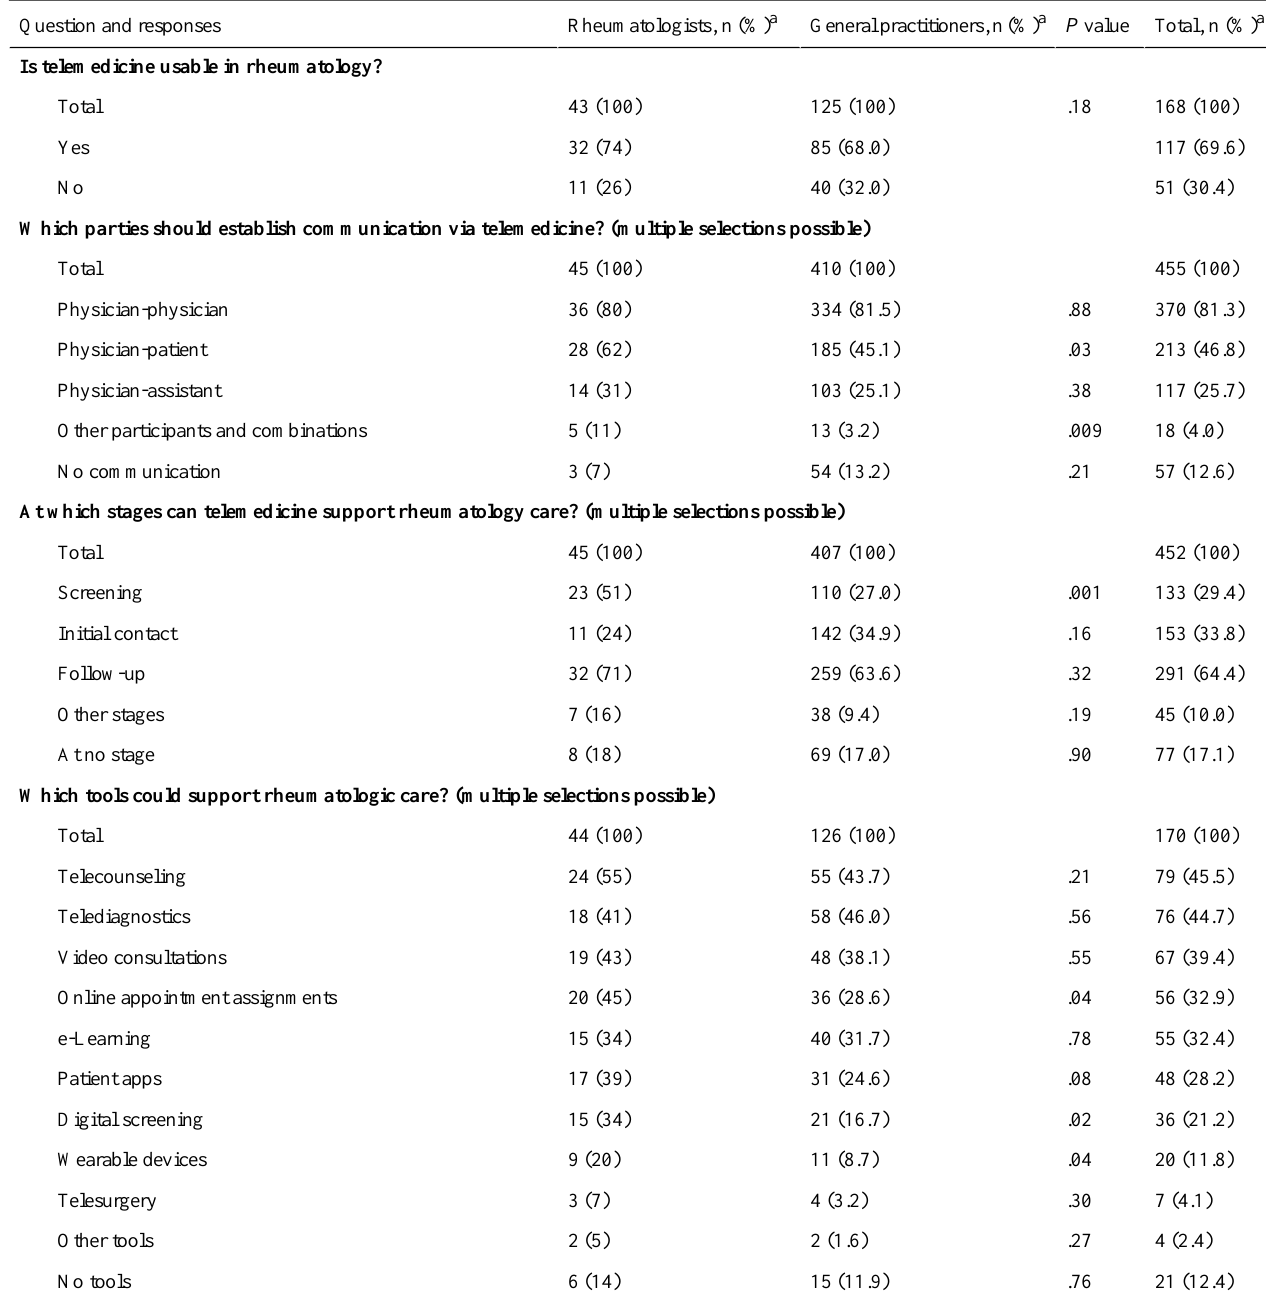
Table 3. Implementation of telemedicine in rheumatology care.